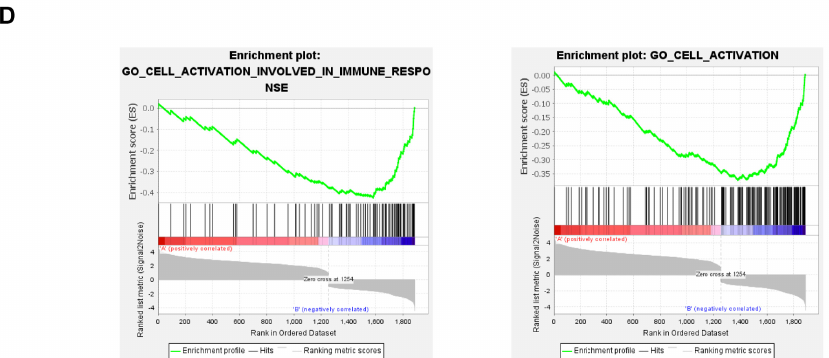
Figure 1. Identification of differentially expressed genes (DEGs) by transcriptome sequencing and functional analysis in IR rat hearts. ( A ) Hierarchical cluster analysis of RNA sequencing data. ( B ) Volcano plot depicting the differential RNAs, with the vertical lines corresponding to 2-fold up- and downregulation and the horizontal line representing a p value of 0.05. ( C ) GO analysis of differentially expressed RNAs. ( D ) GSEA enrichment plots for two hallmark gene sets enriched in IR rat hearts.